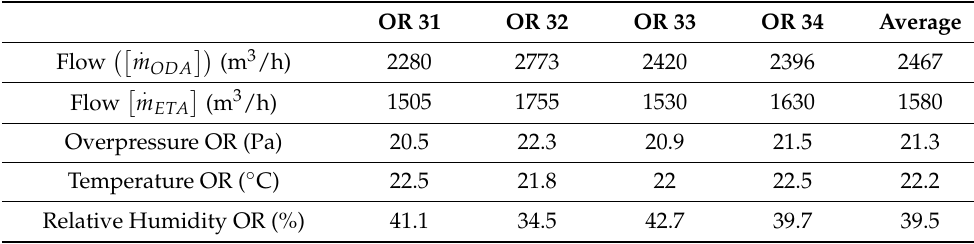
Table 5. Operating Parameters of the ORs under